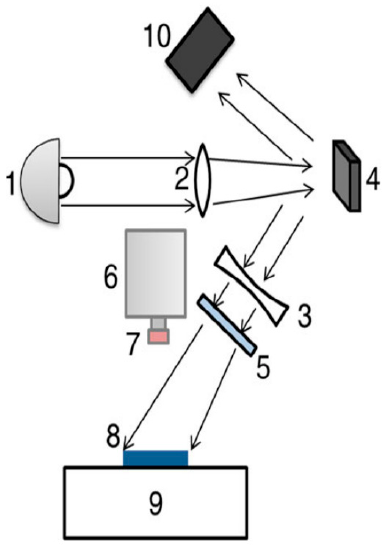
Figure 3. Proposed PL setup in [31]: (1) UHP lamp and concave mirror; (2) and (3) lens; (4) DMD; (5) 950 nm short pass filter; (6) Si CCD camera; (7) long pass filter; (8) sample; (9) stage; and (10) light sink [30].